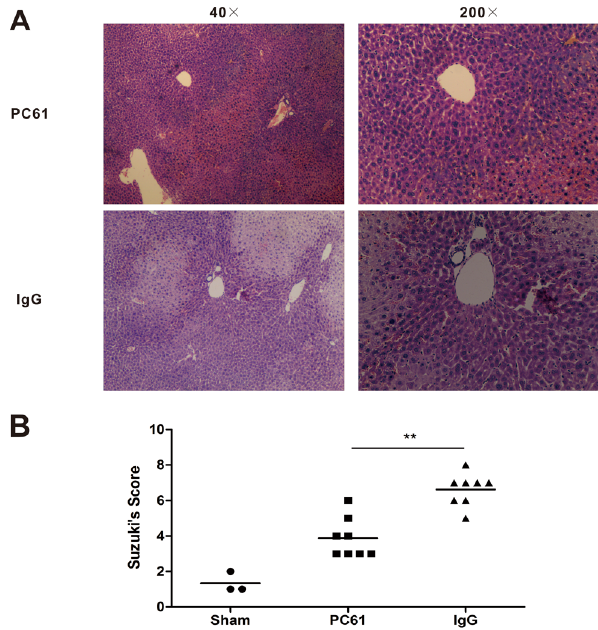
Figure 3. Anti-CD25 mAb pretreatment preserved liver func- tion after hepatic IR. (A) Hematoxylin and eosin staining of liver right lobe harvested at 6 hours post reperfusion (40 6 , 200 6 original magnification). Sections are representative of 6 independent mice per group. (B) Scoring of the ischemic liver sections according to the Suzuki’s criteria. (*p , 0.05, **p , 0.01, ***p , 0.001).